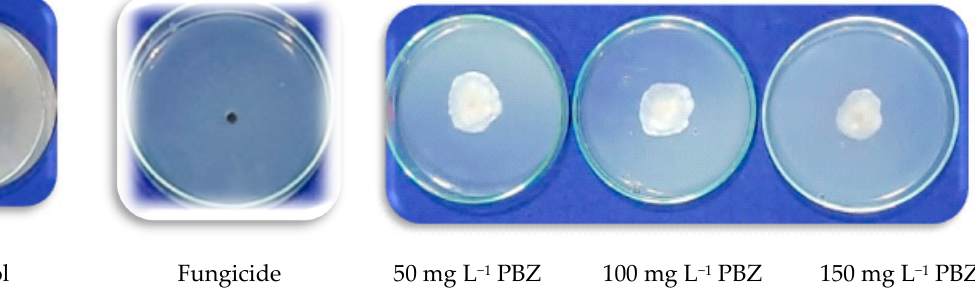
Figure 1. In vitro antifungal activity of paclobutrazol (PBZ) under different applied doses against Rhizoctonia solani , where there is no significance among the applied doses on growth of mycelium compared with recommended fungicide (Rizolex 50% WP) .